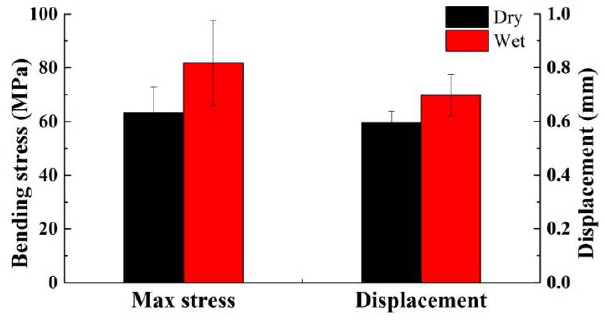
Figure 14. Comparison of stress and displacement for dry and wet samples.